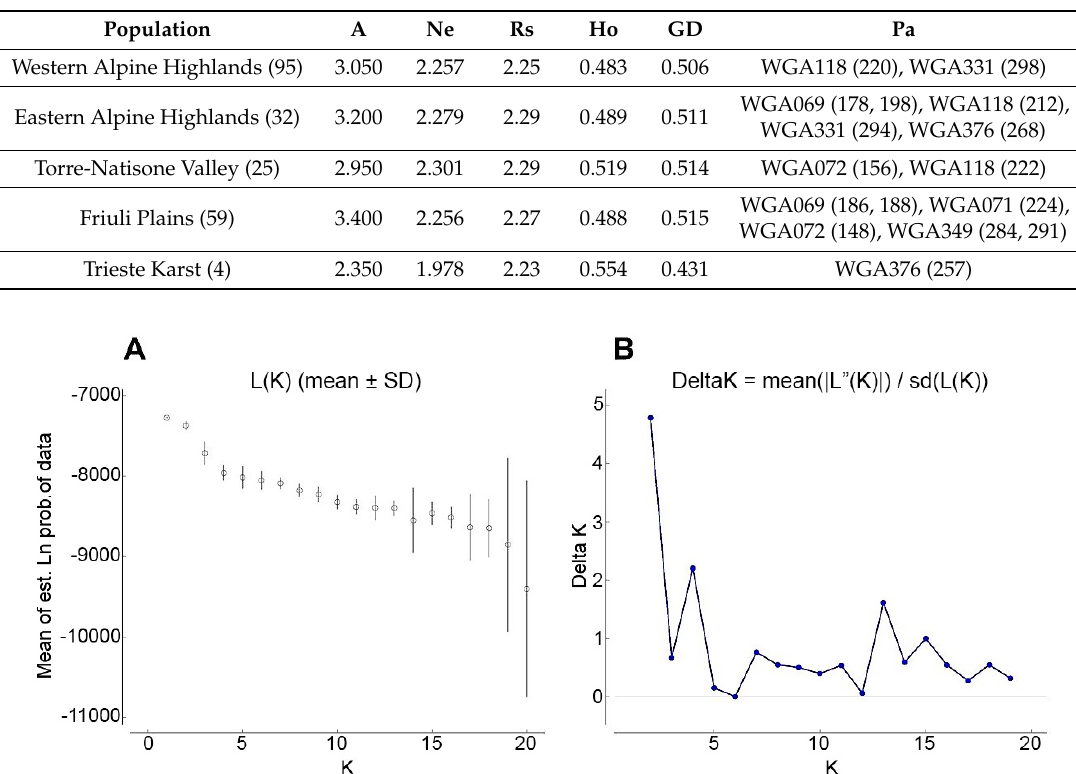
Table 5. Genetic diversity within the five populations of Persian walnut (between brackets the no. of samples) collected in the Friuli Venezia Giulia Region assessed with 20 SSR loci. A = no. of alleles, Ne = effective no. of alleles, Rs = allelic richness, Ho = observed heterozygosity, GD = gene diversity, Pa = private alleles (the private allele length is listed in brackets).